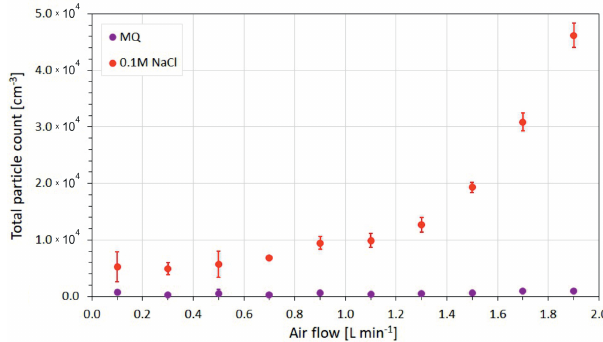
Figure 4. Total aerosol number concentration for MQ and 0.1M NaCl-solution as a function of the flow rate from bubble generation